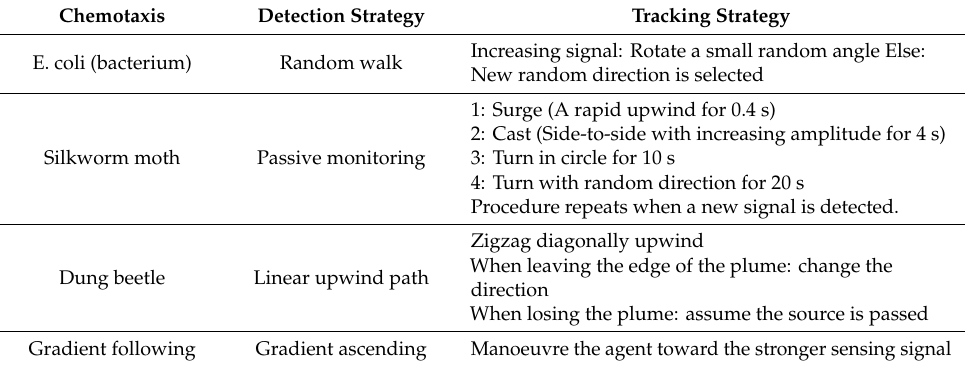
Table 9. Detection and tracking strategies of four chemotaxis algorithms, developed from information in